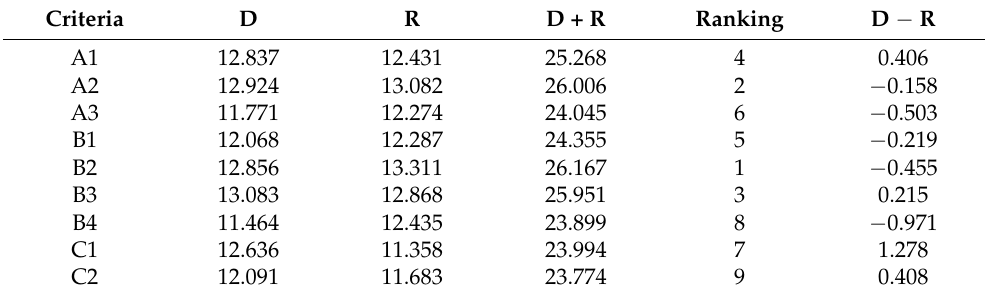
Table 4. Prominence and Relation of Criteria.